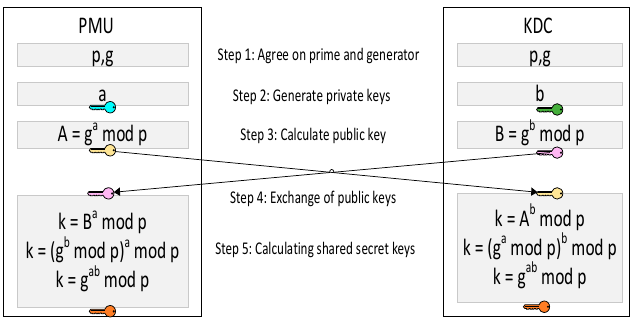
Figure 6. Diffie–Hellman key exchange for authentication. Figure 6. Diffie-Hellman key exchange for